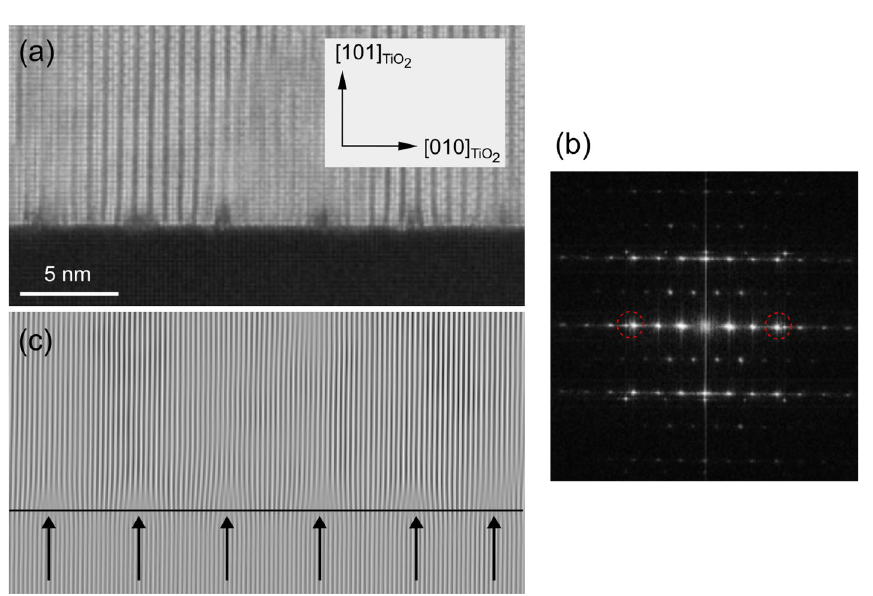
Figure 5. HAADF-STEM images of BSO/(101)Nb:TiO 2 : ( a ) a micrograph, and ( b ) its FFT image. ( c ) The inverse FFT image, which was reconstructed using 020 TiO2 and 600 BSO [spots marked by red circles in ( b )]. The arrows in ( c ) indicate the